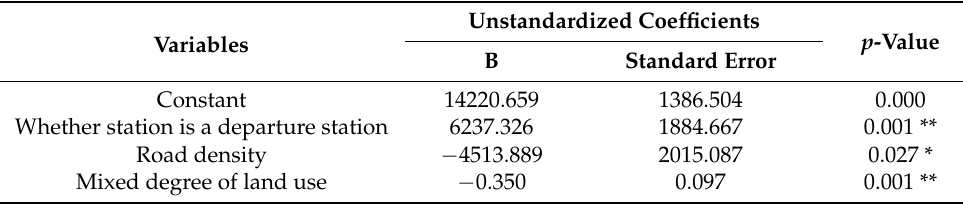
Table 5. Performance of stepwise regression on school commuting